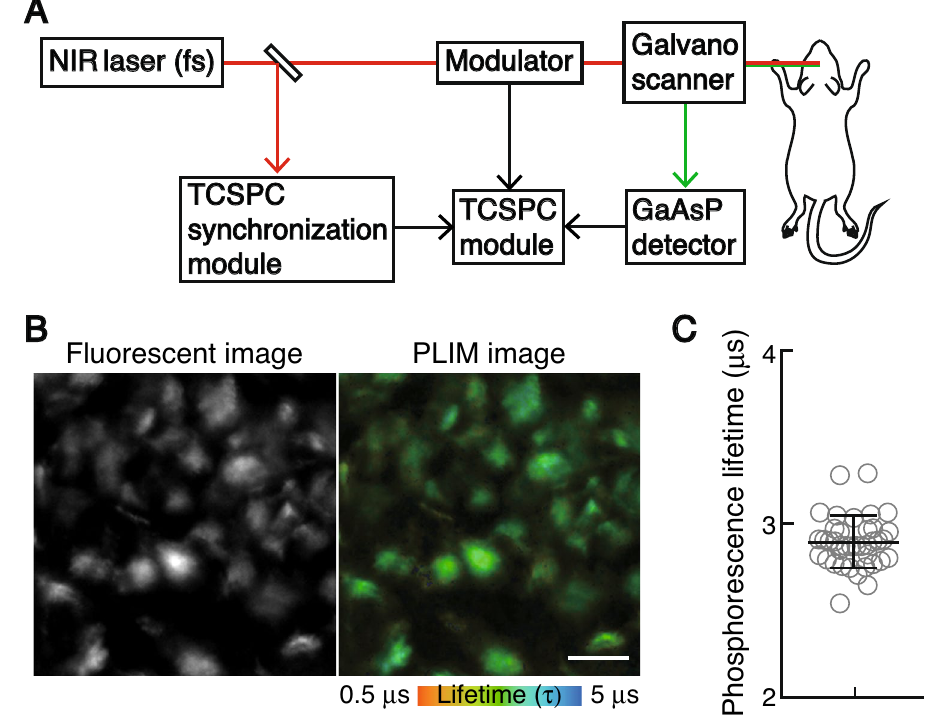
Figure 1. Measurement of the phosphorescence lifetime of the CX 3 CR1-expressing cells of live mice. ( A ) Two- photon phosphorescence lifetime imaging microscopy (2PLIM) setup. ( B ) Representative intravital image of the calvarial bone marrow of CX 3 CR1 GFP/ + mice treated with BTPDM1 showing CX 3 CR1-expressing cells (left, green fluorescent protein [GFP] fluorescence) and 2PLIM image (right, phosphorescence lifetime of BTPDM1). Scale bar, 20 μm. ( C ) Phosphorescence lifetime in each CX 3 CR1-expressing cell of the calvarial bone marrow of mice upon exposure to ambient air. Data points (n = 39) represent single cells collected from four mice. Data denote the mean ±